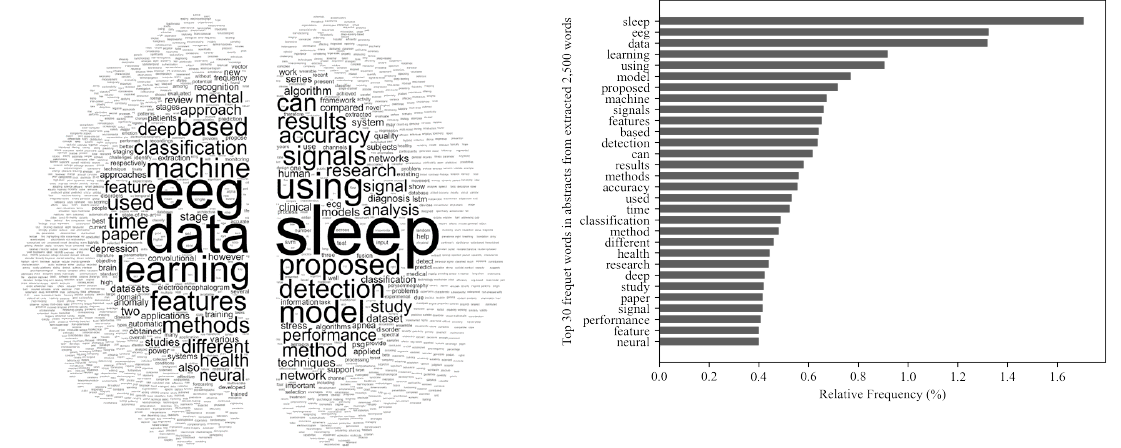
Figure 4. Word cloud and bar graph of all the abstracts of the articles used in this review.